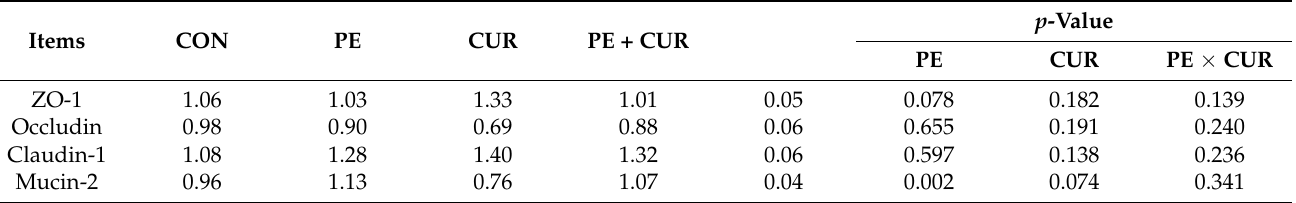
Table 7. Effects of dietary supplementation with PE and CUR on the mRNA levels of